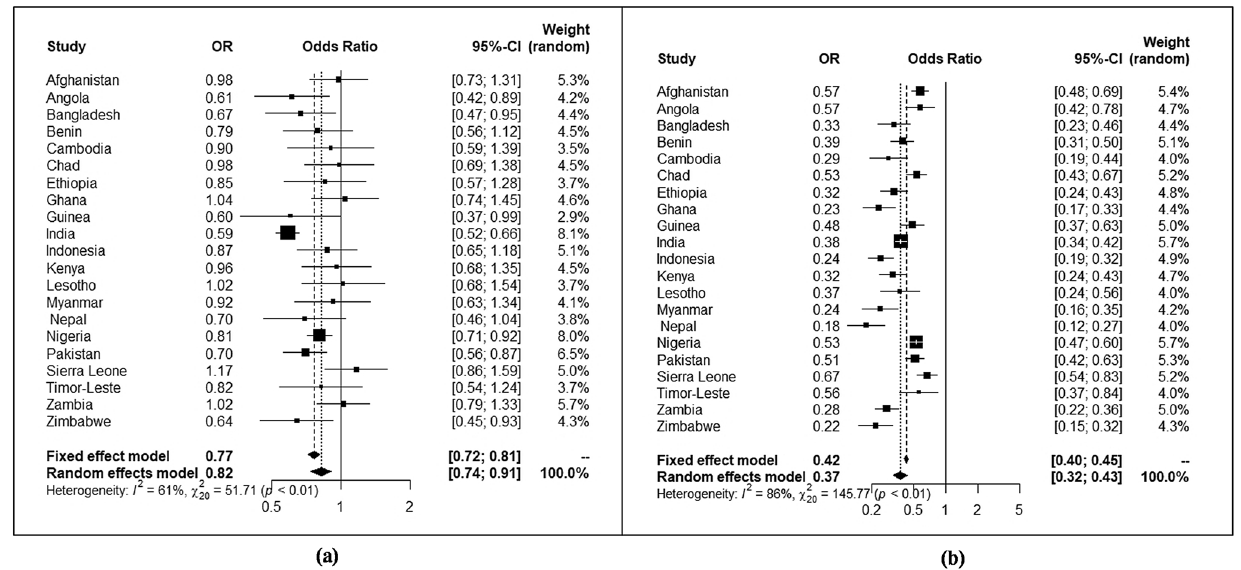
Fig. 2 Forest plot for a mother’s education and b ANC